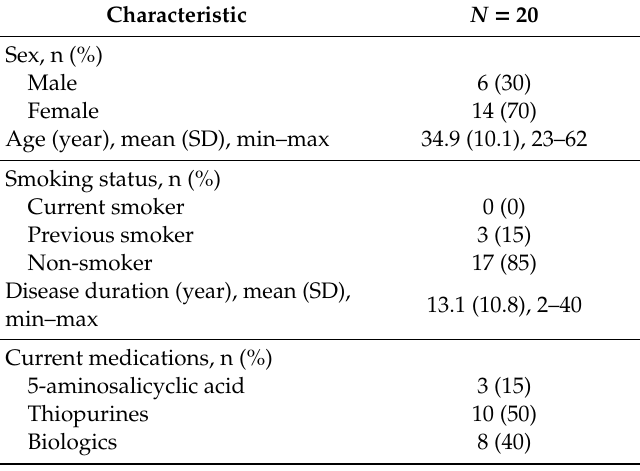
Table 1. Baseline characteristics of 20 participants with Crohn’s disease in the feasibility